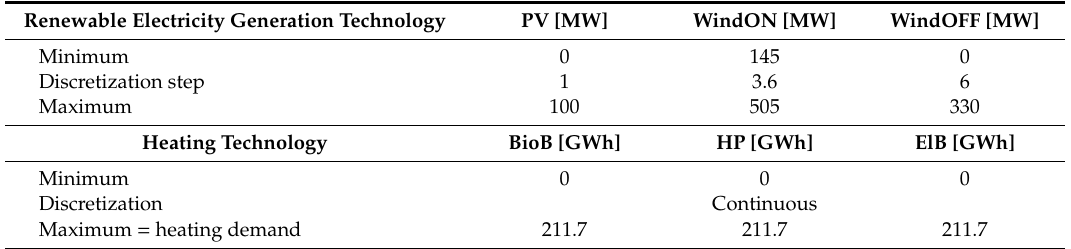
Table 4. Decision variables for local renewable electricity generation and heating